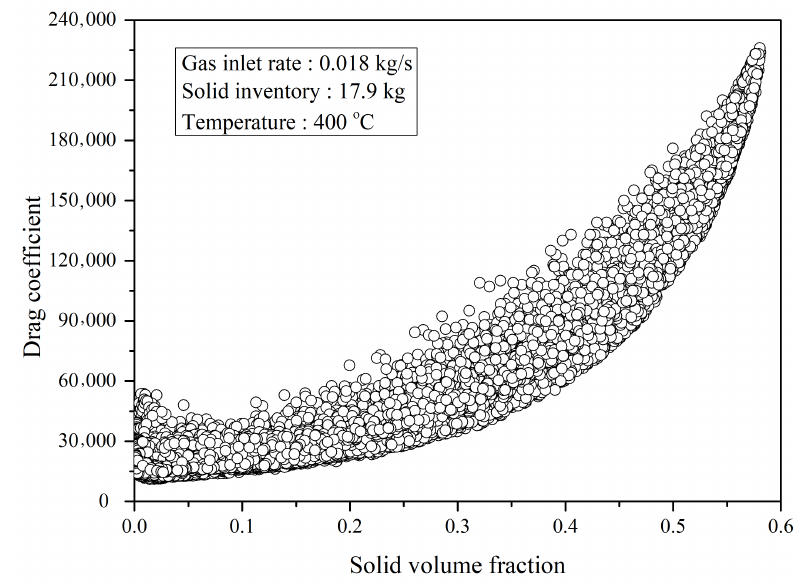
Figure 12. Profile of drag coefficient versus solid volume fraction.